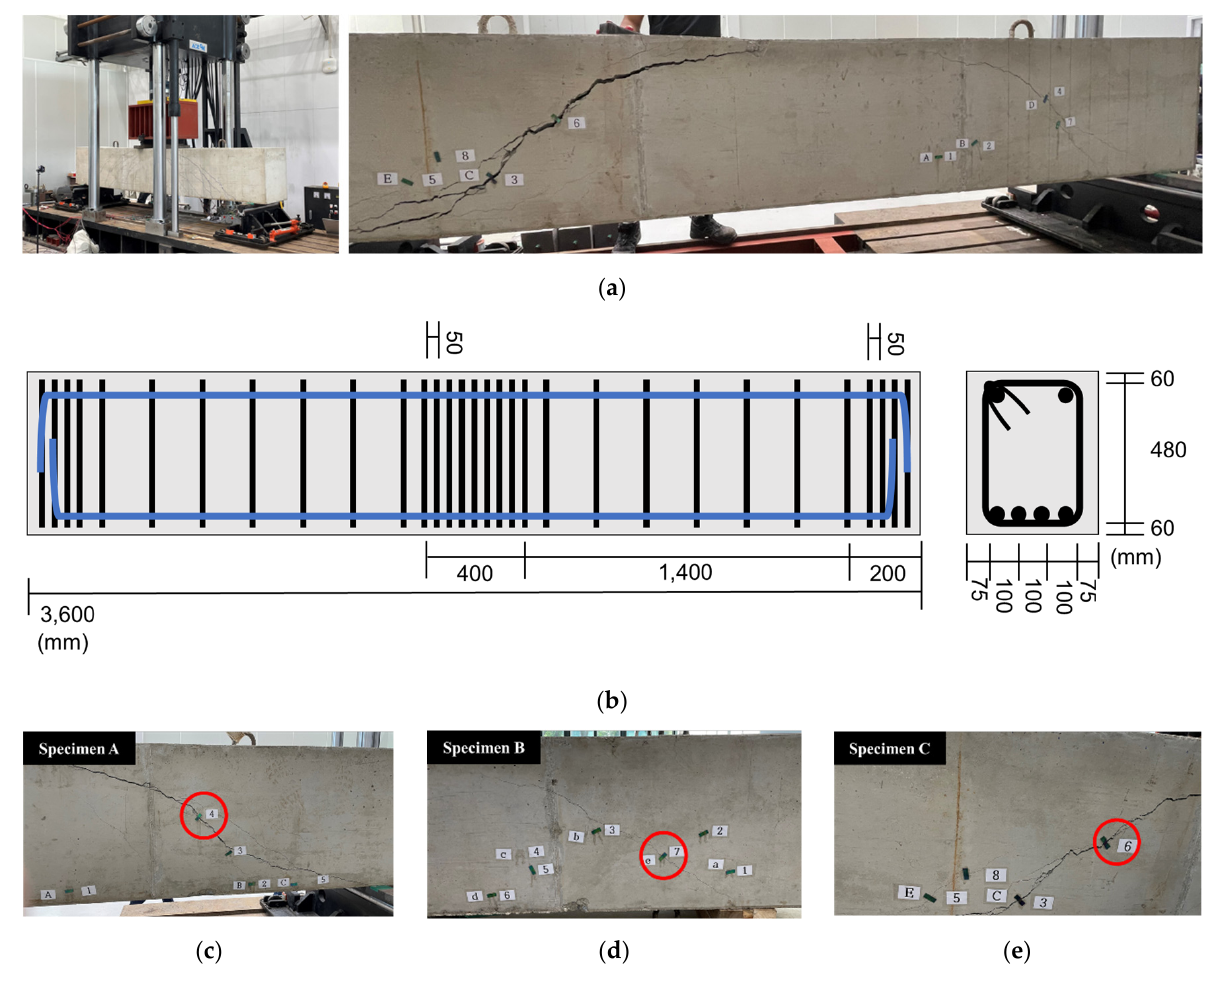
Figure 13. Experimental monitoring of the crack development in concrete beam members. ( a ) Concrete beam member for verification of concrete deformation of mechanochromic sensor; ( b ) design section of a concrete beam member; ( c ) specimen A; ( d ) specimen B; ( e ) specimen C.